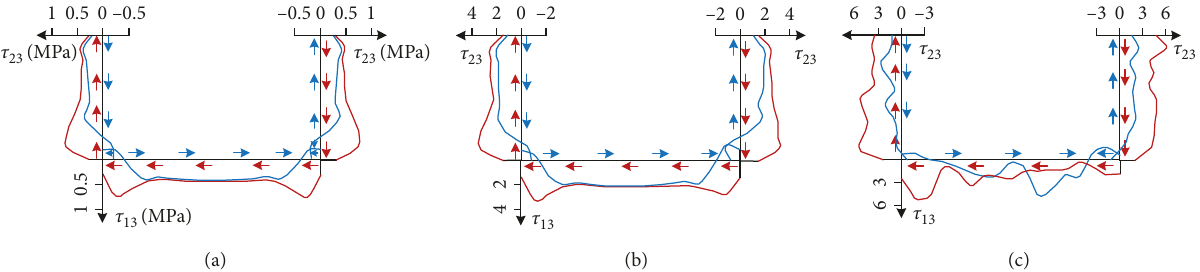
Figure 22: Shear stress distributions around support section at different loading levels of (a) 10% ultimate torque, (b) 30% ultimate torque, and (c) 80% ultimate torque.